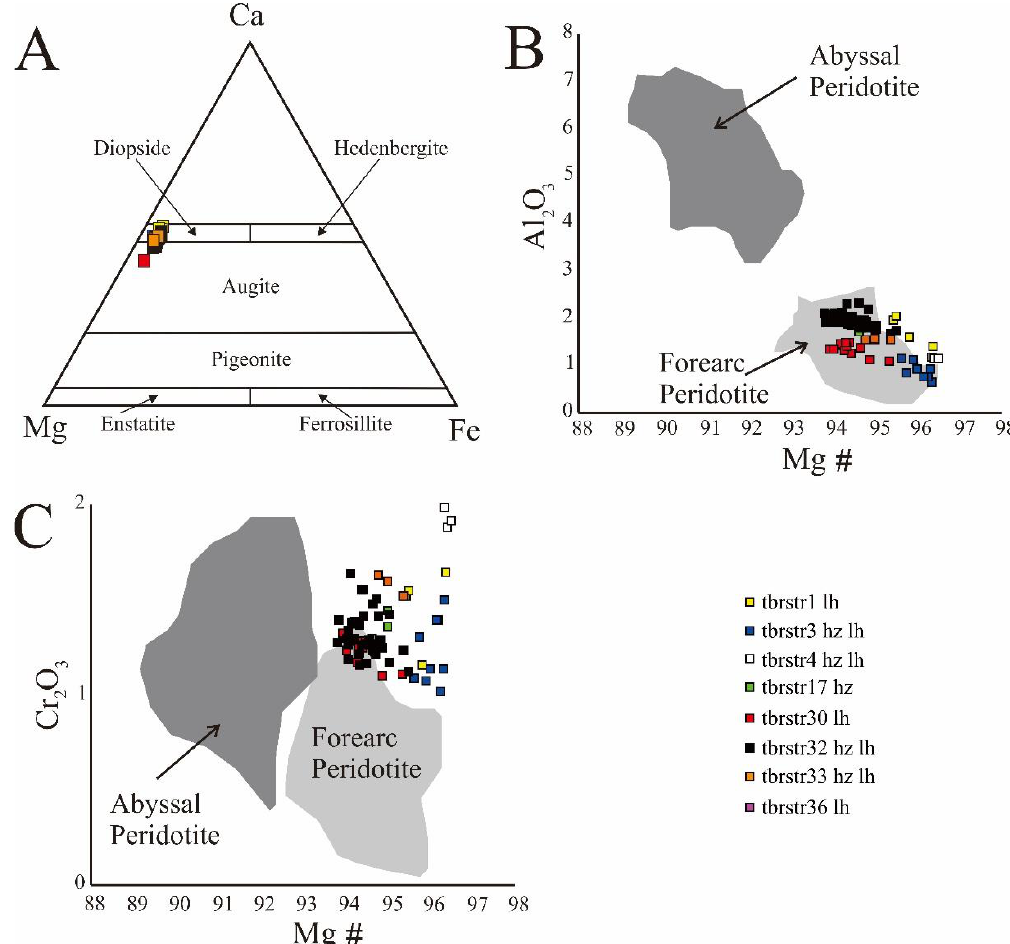
Figure 9. Composition of clinopyroxene from Kabaena Island chromitite: classification in the ternary diagram of Morimoto [39] ( A ), correlation between Al 2 O 3 (wt%) versus Mg# = Mg/(Mg + Fe 2+ ) ( B ), and variation of Cr 2 O 3 (wt%) and Mg# ( C ). Compositional fields from Rogkala et al. [40] and Lian et al. [41].